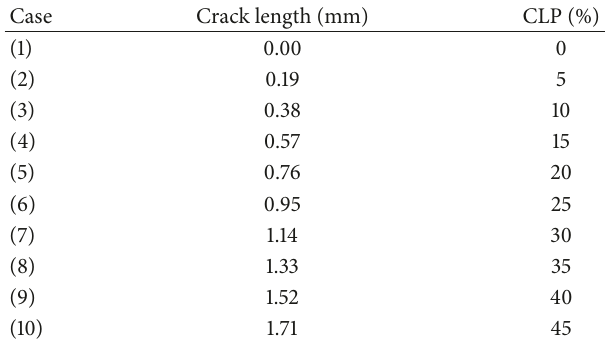
Table 1: Gear parameters used [3].